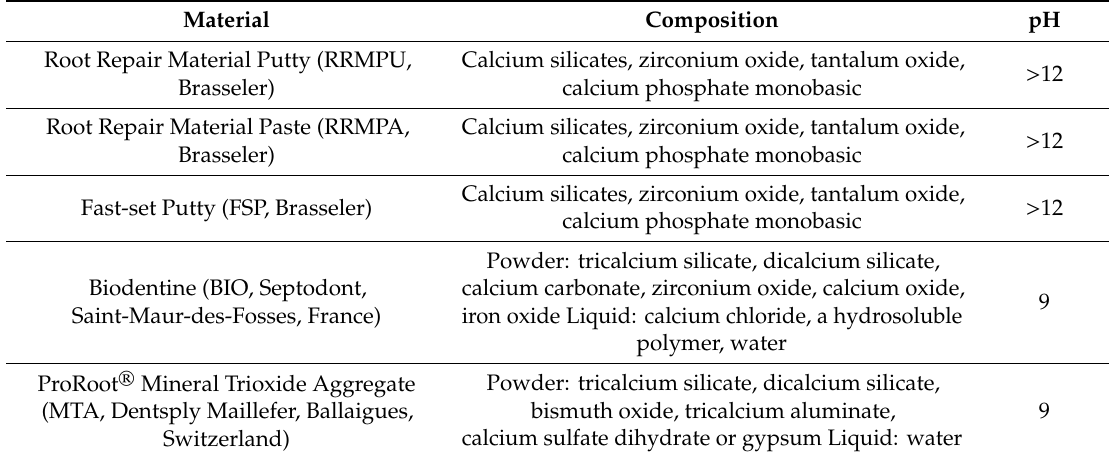
Table 1. Chemical formulation of the tested materials: Root Repair Material Putty (RRMPU, Brasseler), Root Repair Material Paste (RRMPA, Brasseler), Fast-set Putty (FSP, Brasseler), Biodentine (BIO) and ProRoot ® MTA.